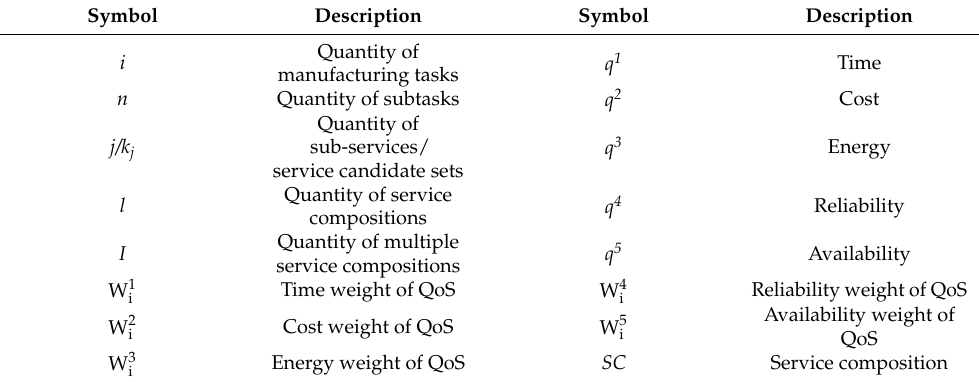
Table 5. The description of symbols.